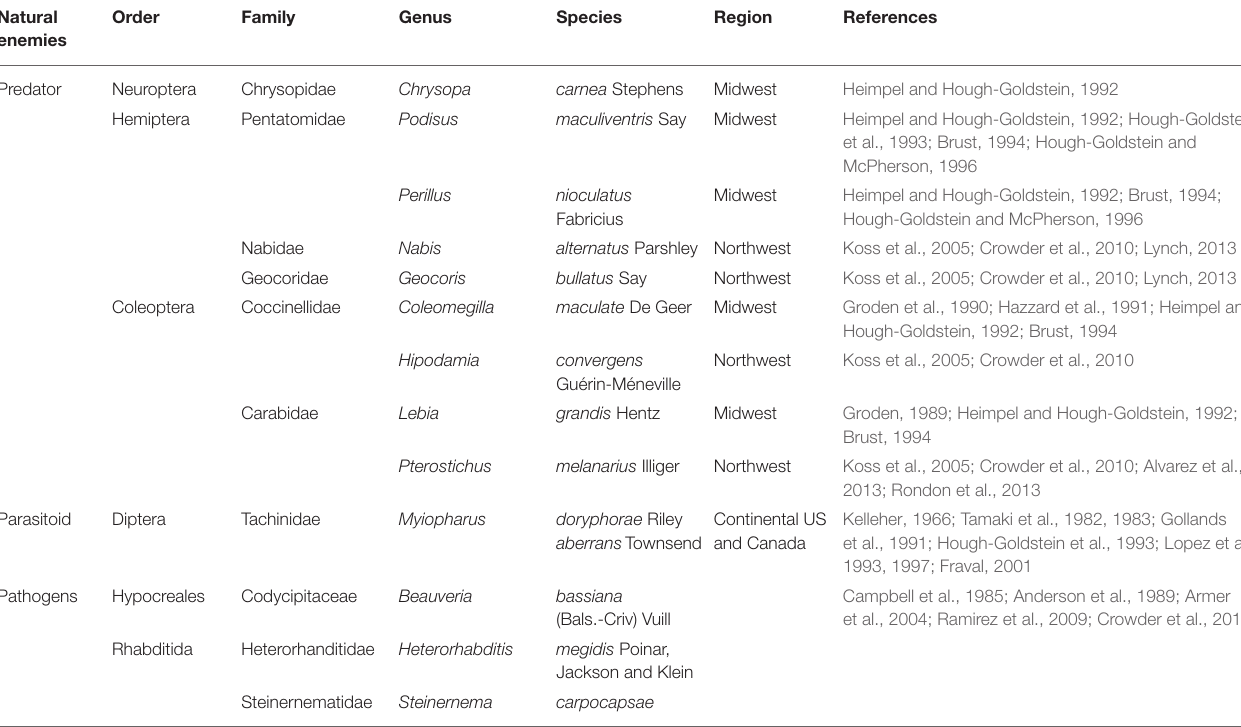
TABLE 2 | Natural enemies of Leptinotarsa decemlineata